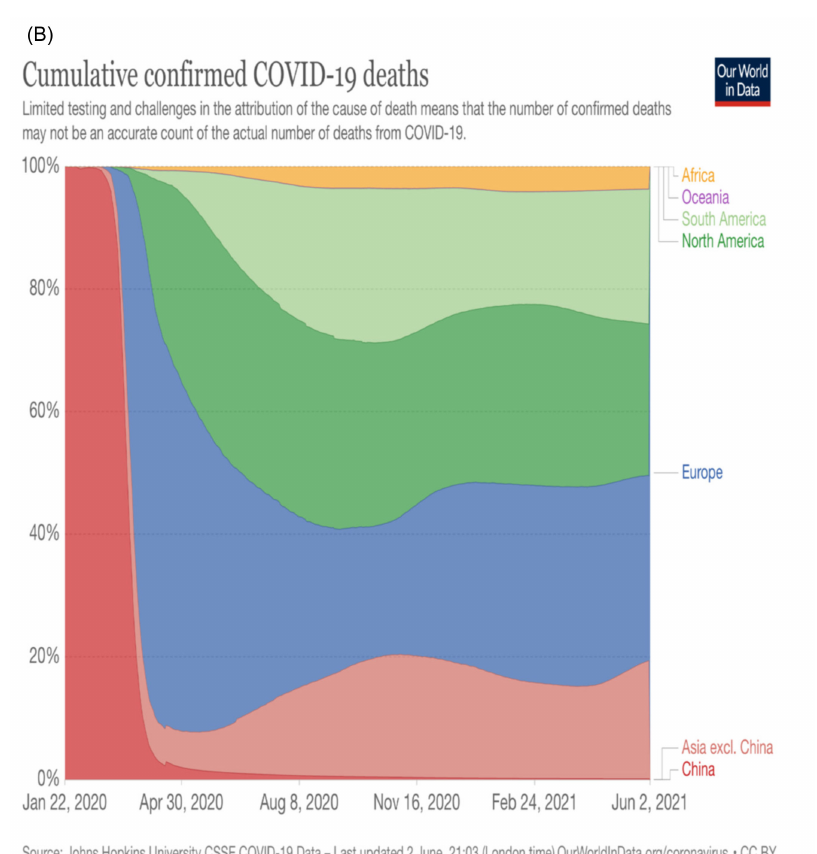
Figure 4. ( A ). Model for the relationship between the people with codon 72 SNP of p53 variants of earth’s northern latitude or equator region and inflammatory response to viral (SARS-CoV, SARS-CoV-2)/bacterial infections. ( B ). Relation between the confirmed mortality rate of virus-infected patients and proximity to the equator. It aligns well with the innate immune response and geographical distribution of codon 72 polymorphism of p53. The mortality rate is much higher in countries further north to the equator, with R72 variant populations, compared to countries near the equator, with P72 variant